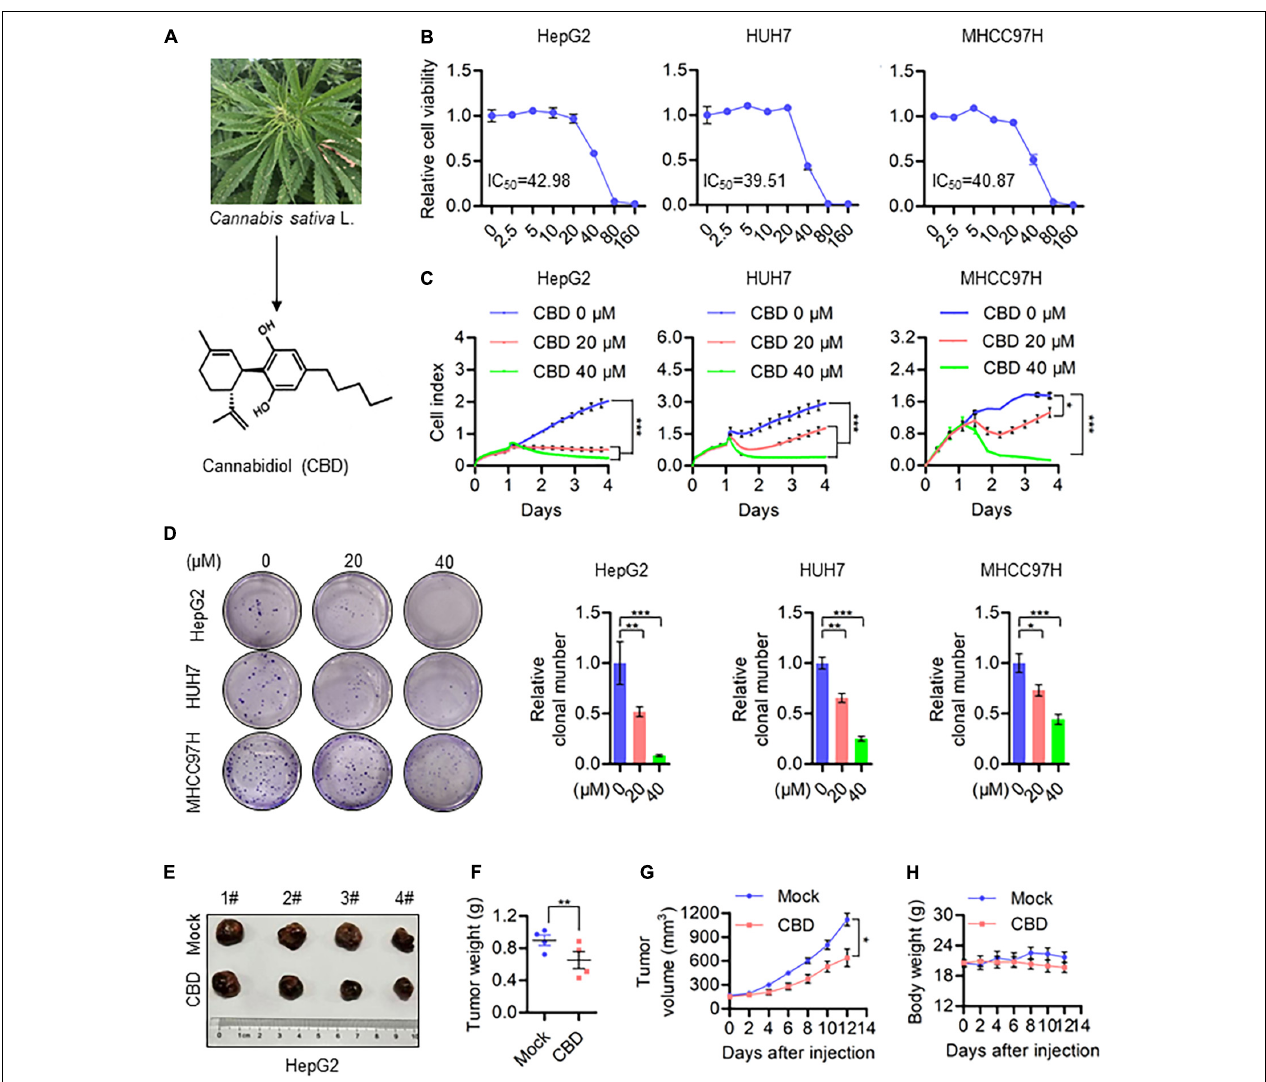
FIGURE 1 | CBD inhibits HCC cell growth in vivo and in vitro . (A) Chemical structural formula of CBD. (B) These HCC cell lines HepG2, HUH7, and MHCC97H were treated with a gradient concentration of CBD for 24 h. Relative cell viability was analyzed by CCK-8 assay. (C) Cell proliferation of CBD treated HepG2, HUH7, and MHCC97H cells was determined by RTCA (Real Time CelI AnaIysis) according to the manufacturer’s instructions. (D) Representative images of colony formation assay were measured after HepG2, HUH7, and MHCC97H colony initiation being treated to different concentration of CBD for 2 days. The graphs represent the mean ± SD. (E) Representative dissected tumors of physiological mock group and CBD group derived from HepG2 cells were shown after the mice were sacrificed. (F) Changes in tumor weight of mice treated with castor oil or CBD. Data are presented as mean ± SEM ( n = 4). (G) Tumor volume in each mouse was monitored every 2 days. Data are presented as mean ± SEM ( n = 4). (H) Body weight measurements of mice treated with castor oil and CBD. Data are presented as mean ± SEM ( n = 4). The meaning of ‘*‘ is statistically significant. * p < 0.05, ** p < 0.01, *** p < 0.001.